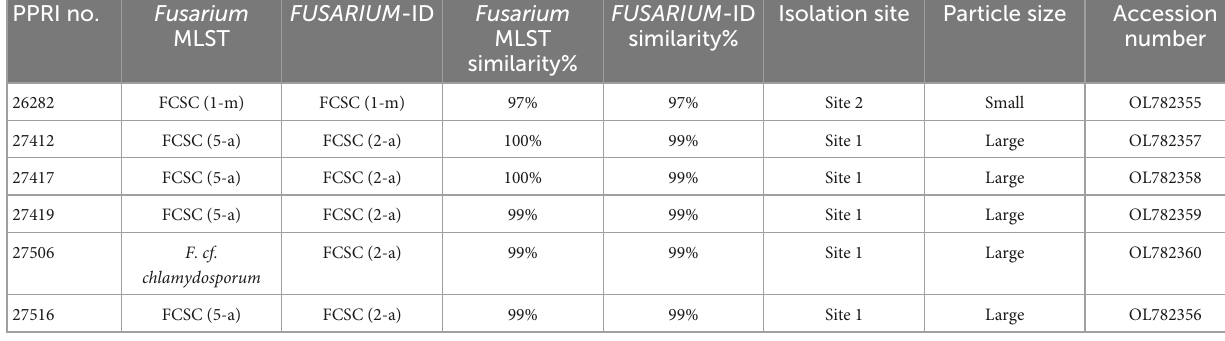
TABLE 6 Nucleotide BLAST (nBLAST TM ) results from the Fusarium MLST and FUSARIUM -ID databases for the FCSC. PPRI no.